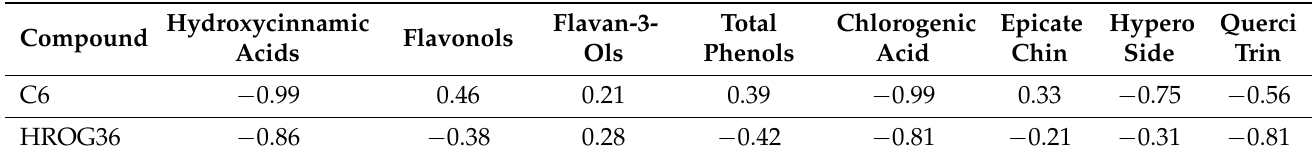
Table 4. The values of coefficient for correlation between viability (metabolic activity) of C6 or HROG36 cells and amount of phenolic compounds in the extracts from leaves of quince cultivars ‘Rondo’, ‘Rasa’, and ‘Darius’. Hydroxycinnamic Compound